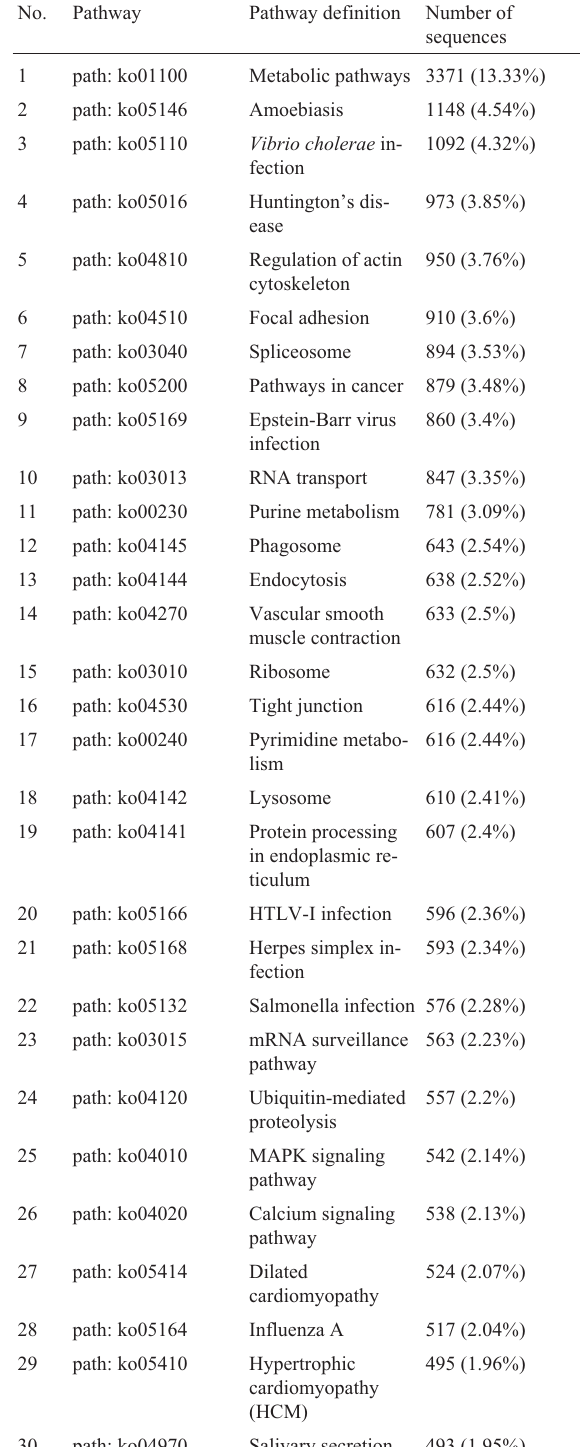
Table 3 - Top 30 statistically significant KEGG classifications.